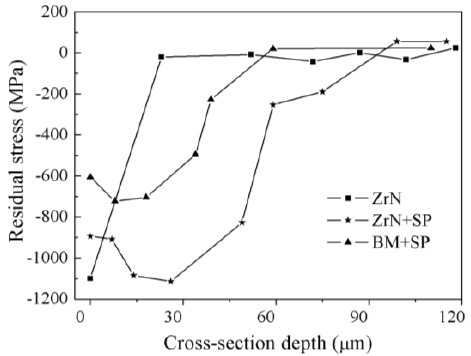
Figure 11. Results of residual stress depth distribution for different state samples.